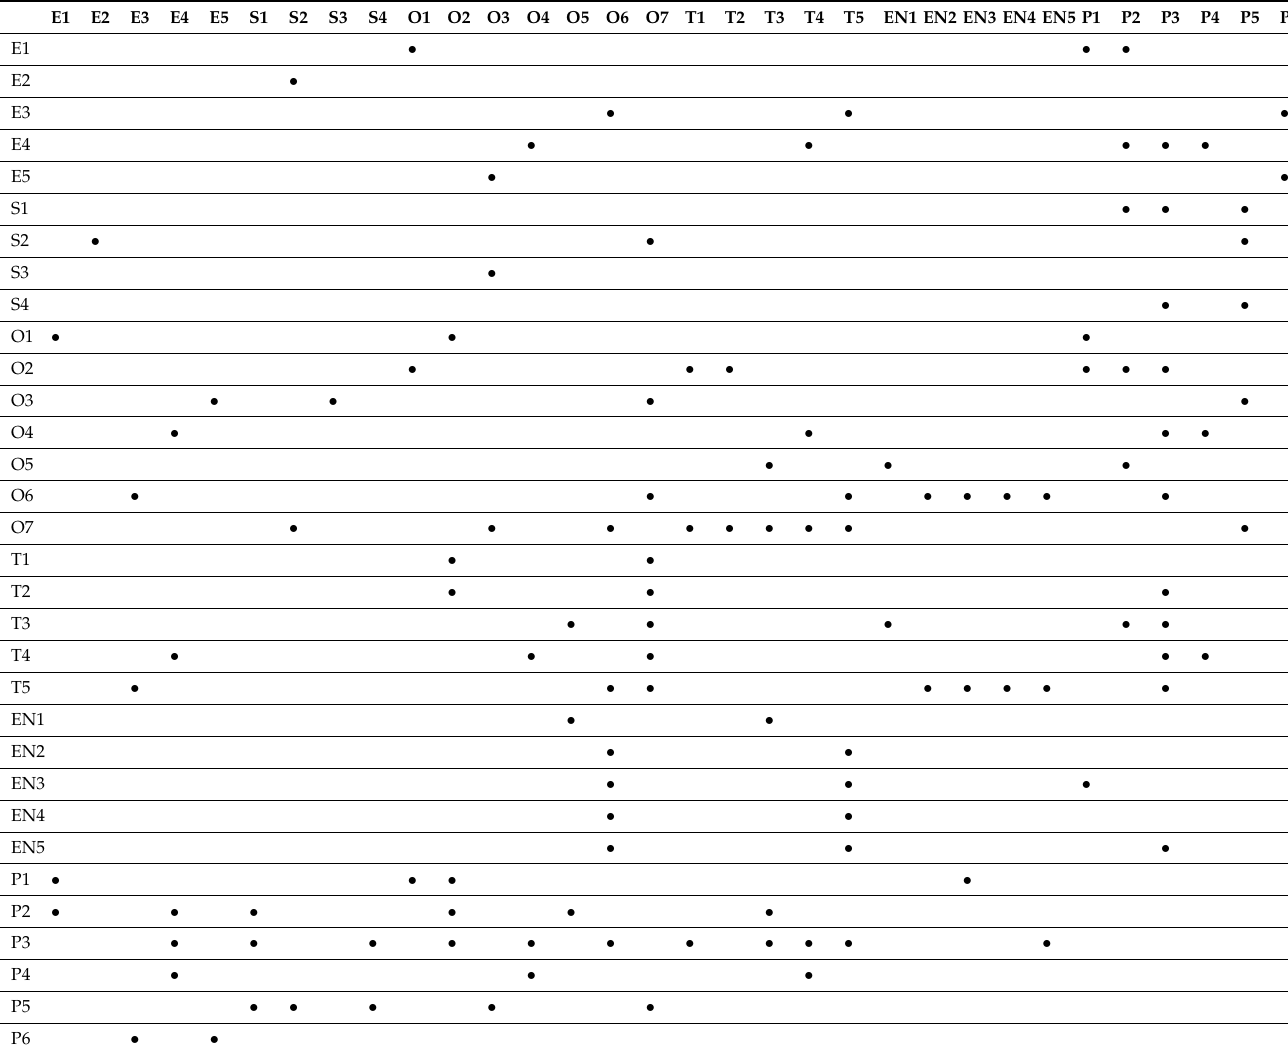
Table 1. Connections between challenges to adopt CE in the existing building